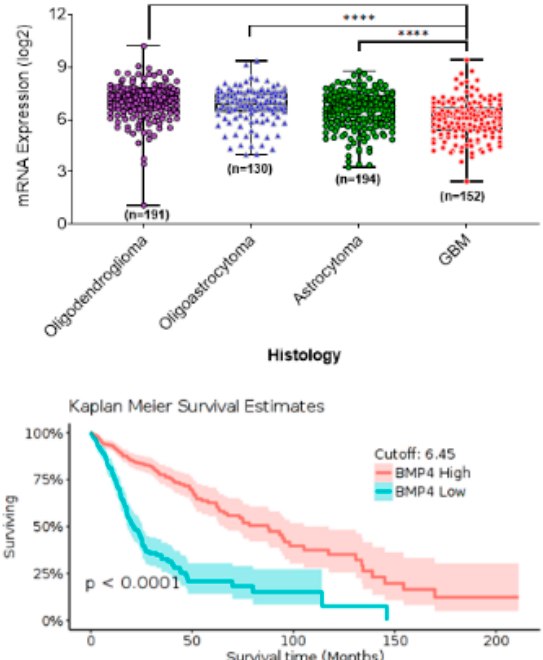
Figure 1. In silico data analysis from The Cancer Genome Analysis (TCGA) using the Gliovis online portal shows BMP4 mRNA expression associated with tumor category based on histology ( top panel ) and patient survival in adult gliomas ( bottom panel ).